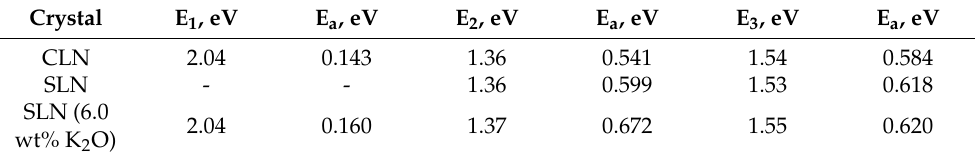
Figure 9. Temperature dependence of normalized PL intensity in the visible region and quenching of luminescence bands at 2.04 for crystals CLN ( a , c ) and SLN (6.0 wt% K 2 O) ( b , d ). Table 5. The position of the maxima and the value of the activation energy for the crystals under